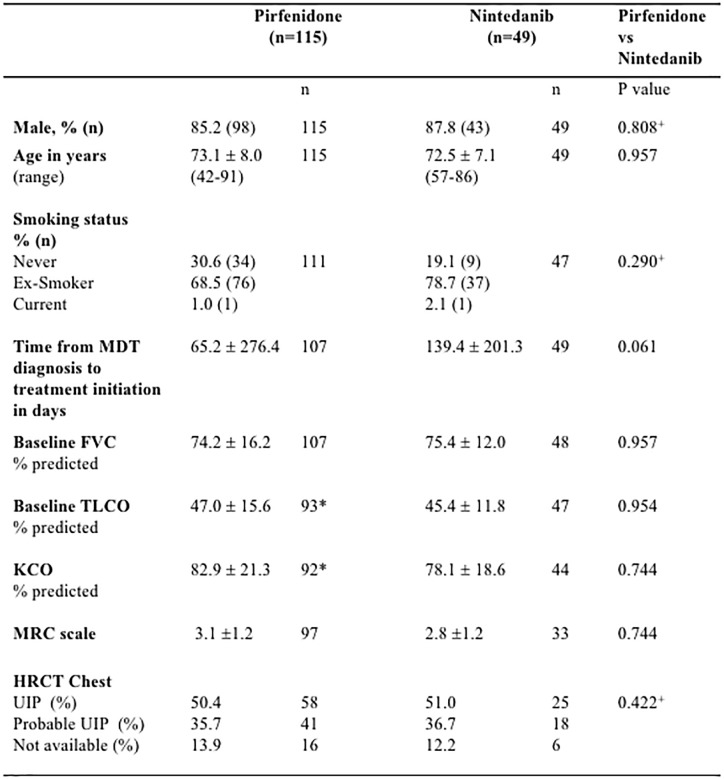
Baseline demographics of Idiopathic Pulmonary Fibrosis (IPF) patients receiving Pirfenidone or Nintedanib. There were no statistically significant differences in baseline demographics between pirfenidone and nintedanib subgroups. n, number; FVC, forced vital capacity; TLCO, transfer factor for carbon monoxide; KCO, transfer coefficient; MRC, medical research council; HRCT, high resolution computed tomography; UIP, usual interstitial pneumonia; SD, standard deviation. ∗ 5 patients were unable to perform the gas transfer maneuver due to cough. HRCT definitions of radiological pattern are as defined by the ATS/ERS/JRS/ALAT 2018 guidelines for IPF (Raghu et al., 2018). Data presented as means with standard deviation unless otherwise stated. Statistical significance of continuous variables were analyzed using Holm–Sidak multiple comparisons analysis, without assuming a consistent SD. + Categorical variables were analyzed using Chi-squared tests. P < 0.05 was considered statistically significant.